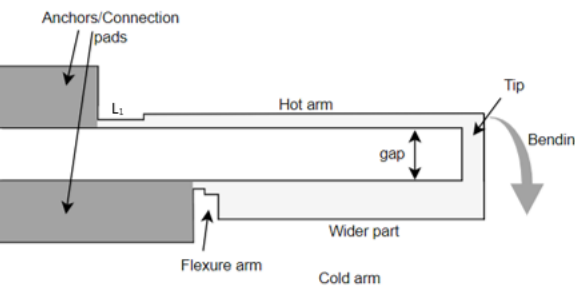
Figure 16. Schematic diagram of design D.